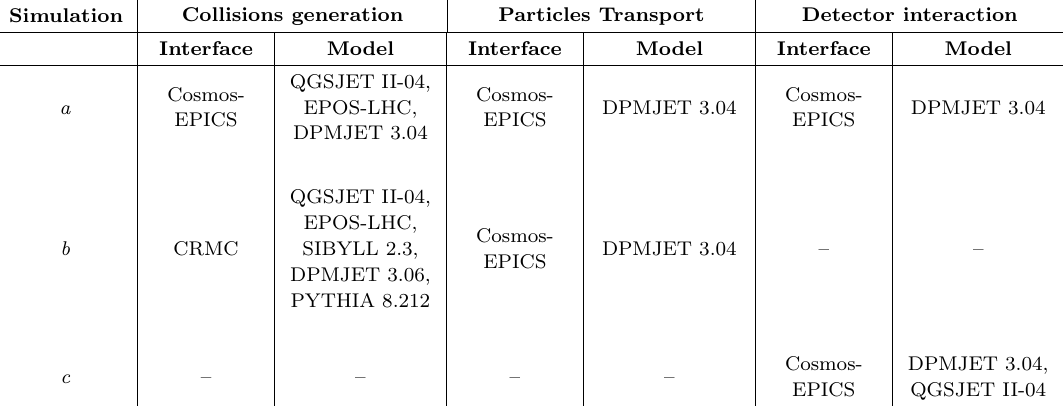
p s = 13 TeV, transport of